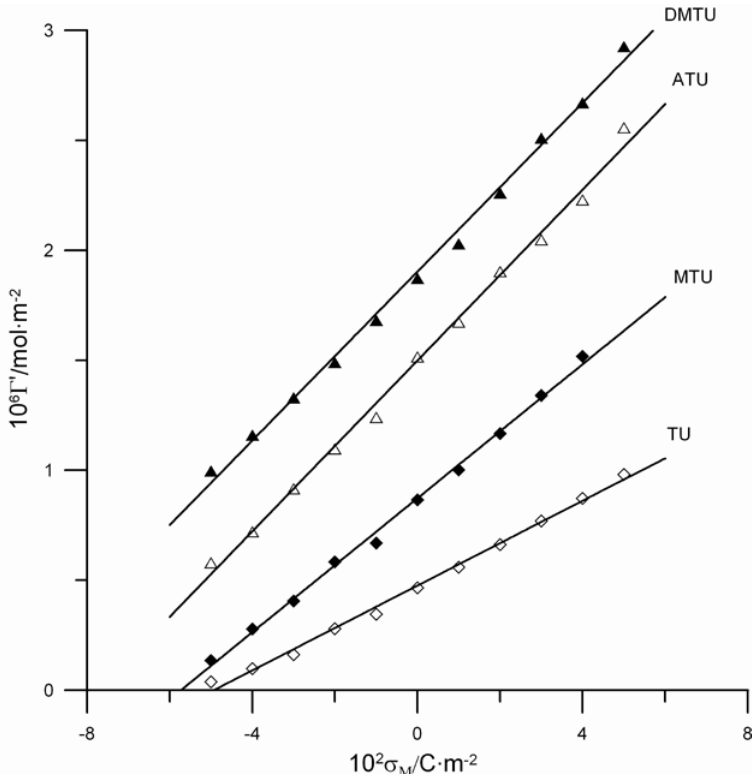
Figure 2. The relative surface excesses ( Г ’) of 3×10 -3 mol dm -3 TU ( ◊ ) [ 33], MTU ( ♦ ), ATU ( Δ ) [ 35] and DMTU ( ▲ ) [ 34] as a function of the electrode